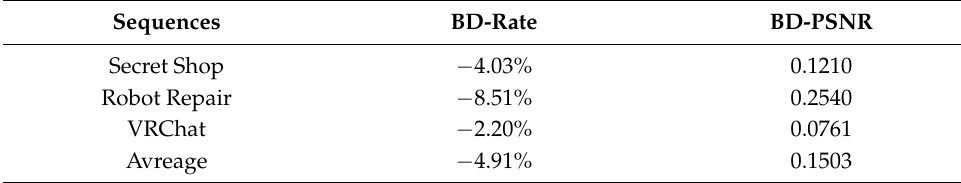
Table 1. BD-Rate and BD-PSNR on test videos relative to